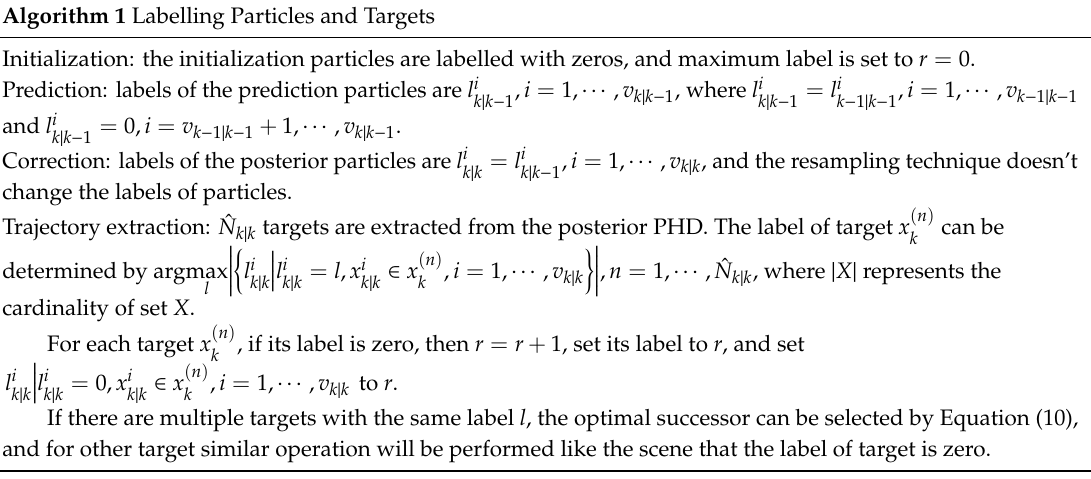
Algorithm 1 Labelling Particles and